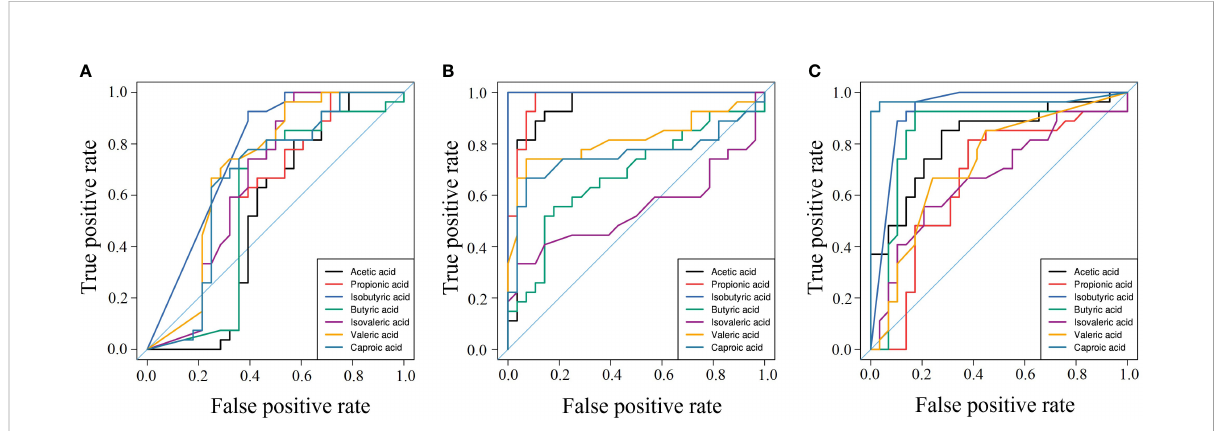
FIGURE 6 Area under the curve of pregnancy complications groups. (A) GDM group, (B) PE group, (C) ICP group. ROC curves for different metabolite combinations. AUC, Area under the curve. AUC>0.5, indicating that it has high predictive